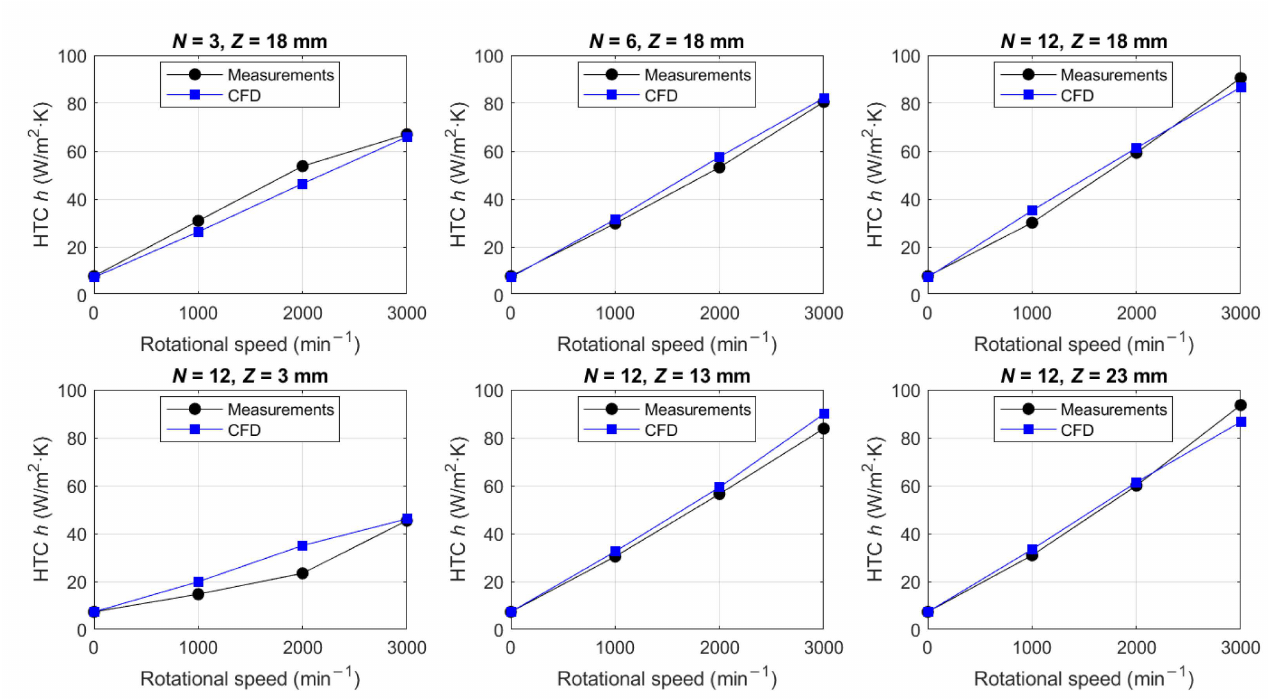
Figure 10. HTC h dependence on rotational speed n . Comparison between CFD values and experi- mental measurement